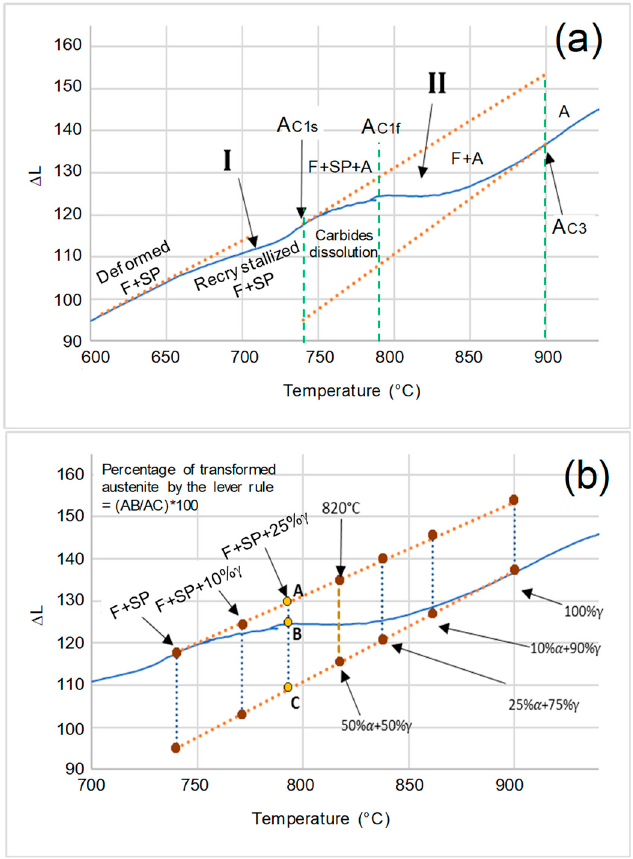
Figure 4. ( a ) Dilation curve obtained on continuous heating of cold-rolled steel as a function of temperature and ( b ) determination of the transformed austenite from the dilation curve by the lever rule method.